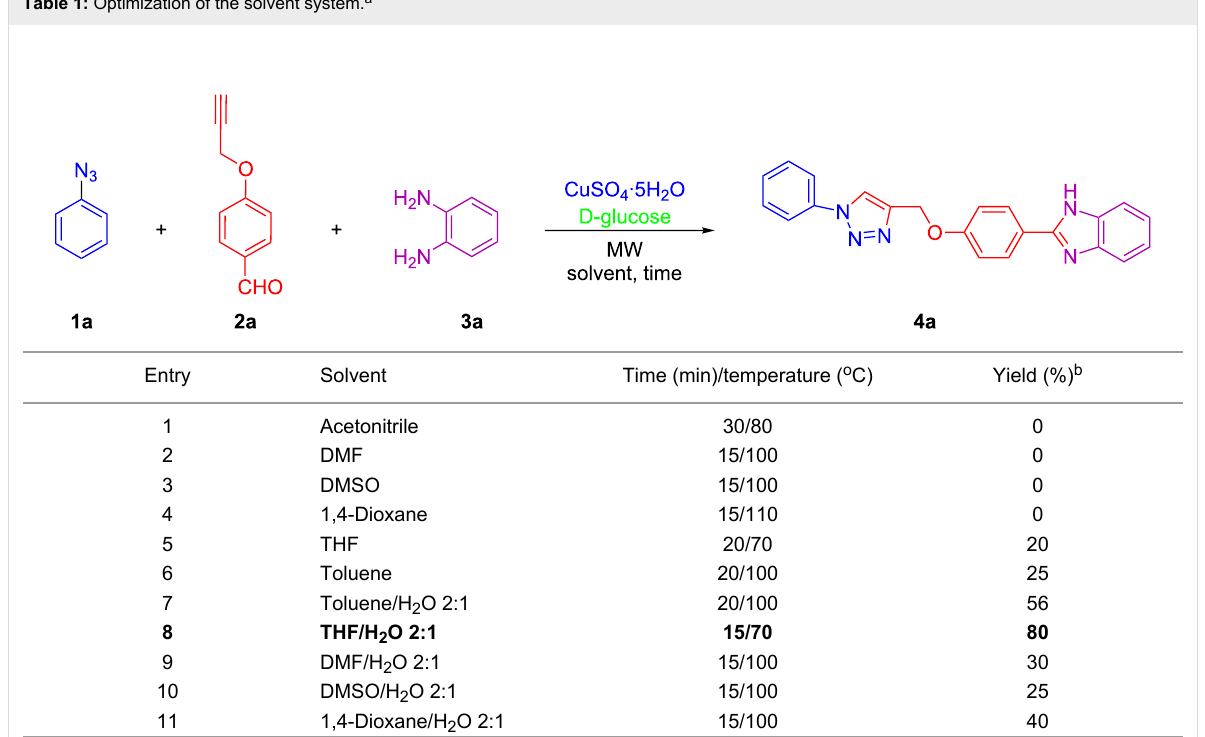
Table 1: Optimization of the solvent system.